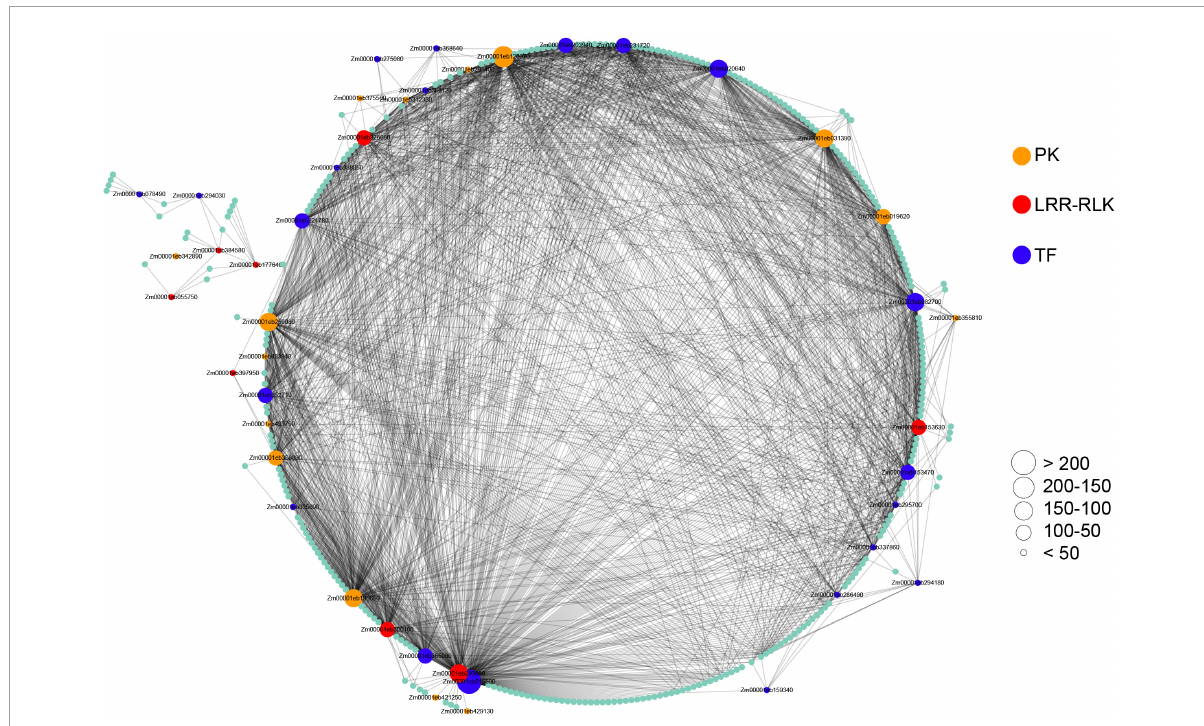
FIGURE6 Co-expressed genes with edge weight > 0.10 in module “salmon.” Each node represents a gene. Co-expressed genes are connected with a gray edge. Node size represents the number of co-expressed genes. PK, protein kinase; LRR-RLK, leucine-rich repeat receptor-like kinase; TF, transcription